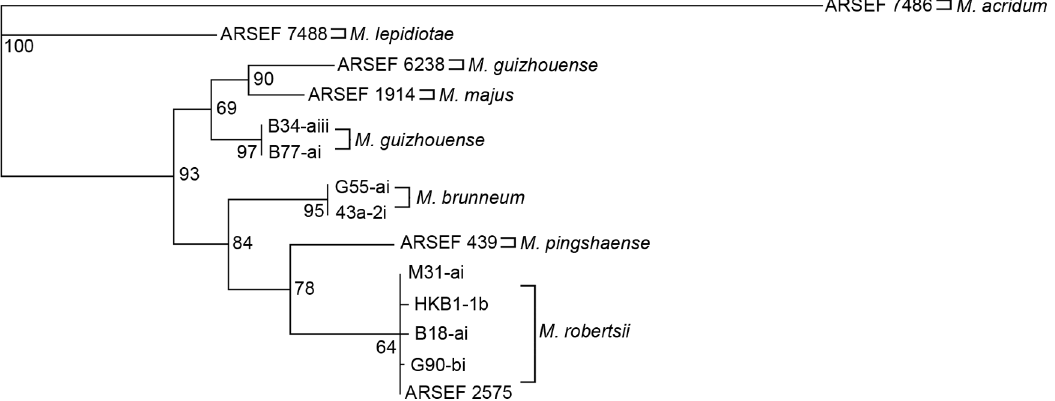
Figure 3. Maximum parsimony (MP) phylogenetic tree of Mad2 full gene sequences of Metarhizium isolates. Bootstrap values are based on 1000 pseudoreplicates.